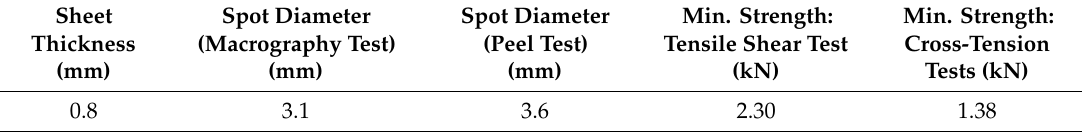
Table 4. Dimensions and minimum tensile strength used for welding spot approval.